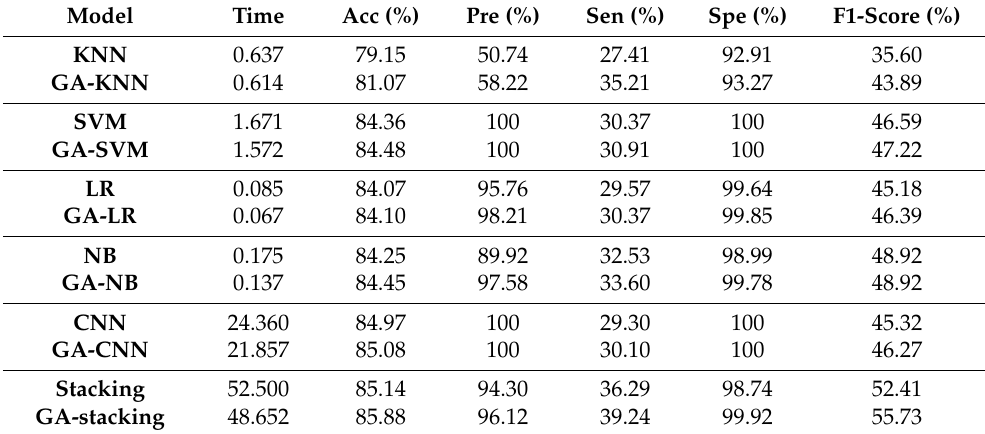
Table 1. Performance of different modules on the Qingdao physical examination data set.